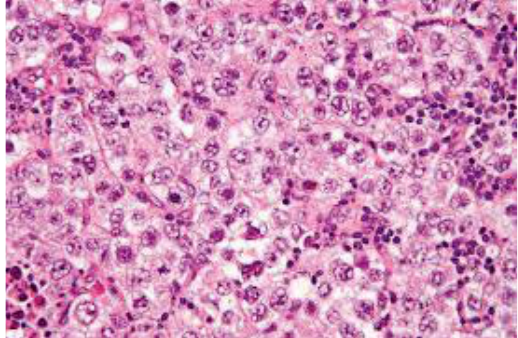
Figure 10.Histopathology of germ cell tumor shows Large, epithelioid cells with abundant cytoplasm, large, round nuclei and irregular and pleomorphic nuclei